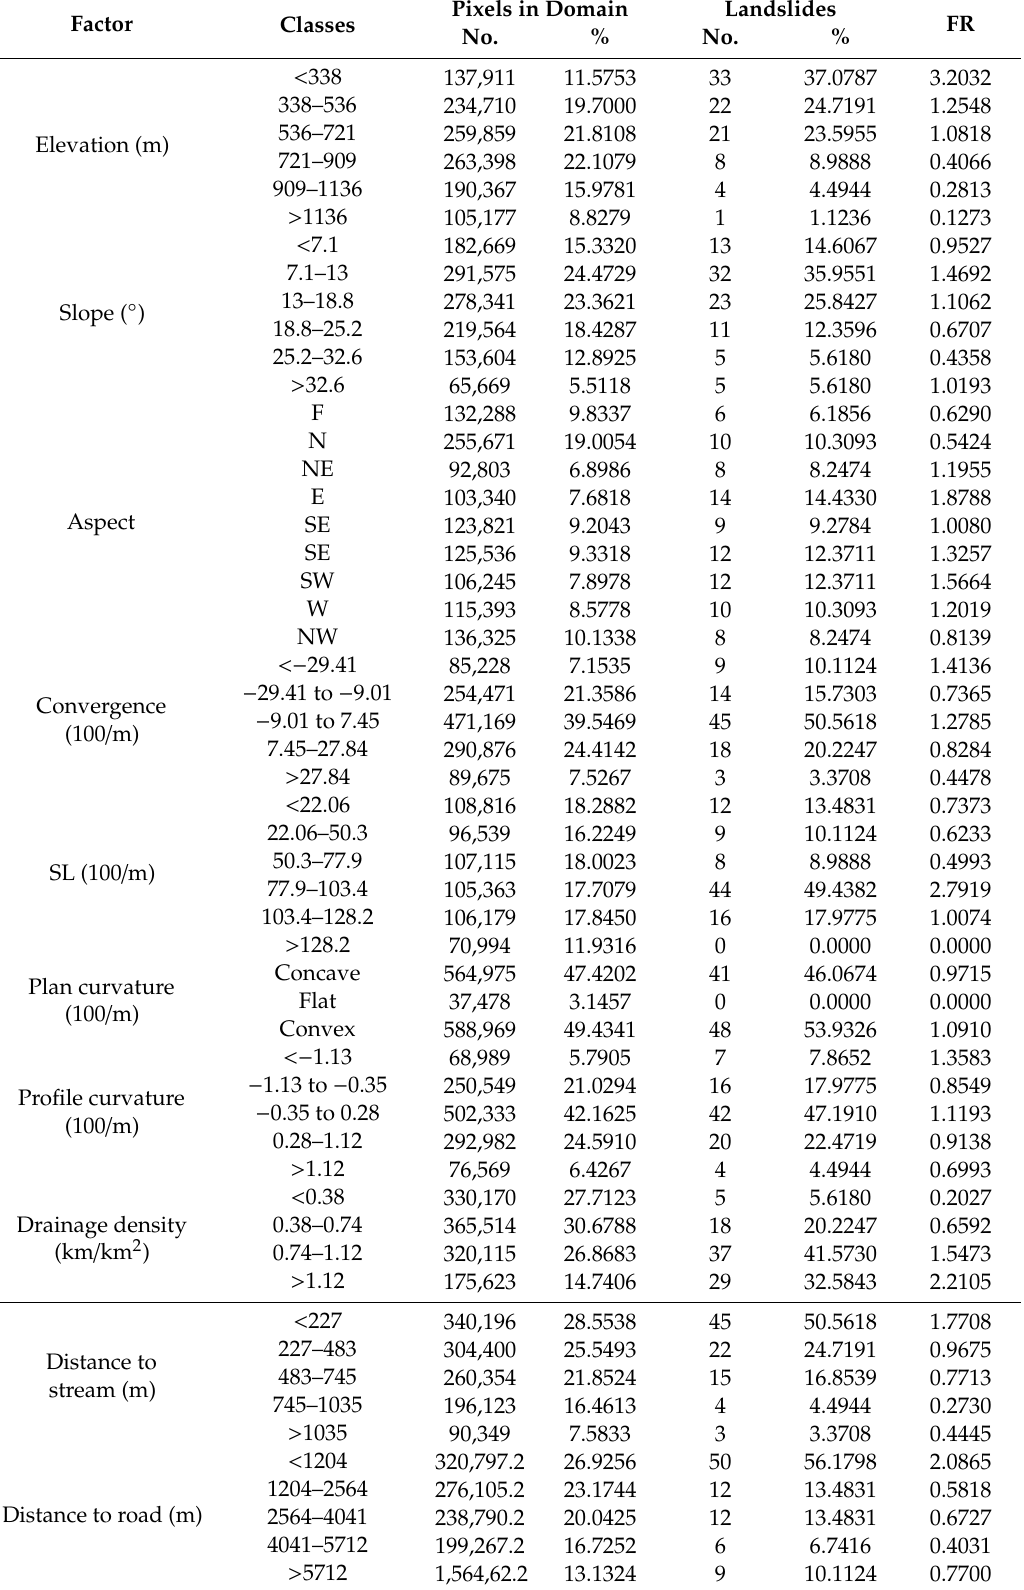
Table 4. Spatial relationship between conditioning factors and landslide locations with frequency ratio